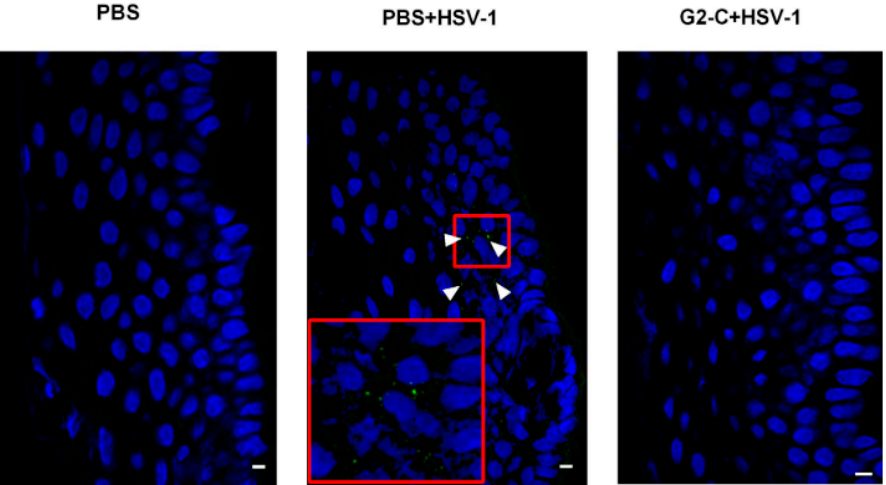
Figure 5. The sections from pig corneas received indicated treatments, where the epithelial cells are shown in blue, while the virus is shown in green. The phosphate-buffered saline (PBS) + HSV-1- treated cells showed the presence of virus while G2-C + HSV-1-treated cells did not. It could be deduced that the peptide, G2-C, released from the contact lens was effective in inhibiting HSV-1 infection, adapted from [87], ARVO Journals, 2016.